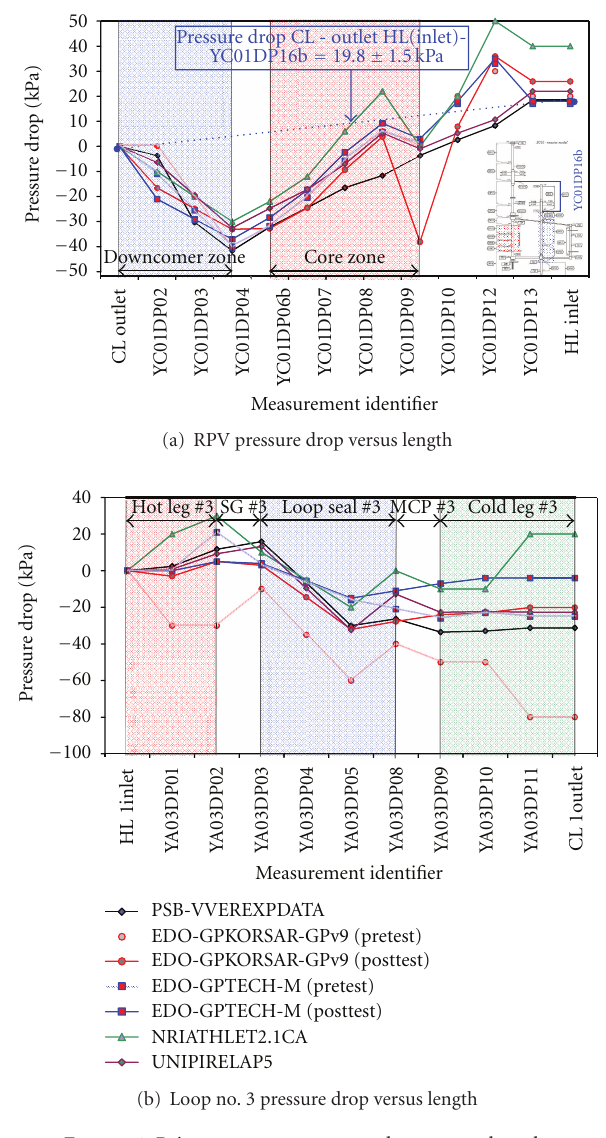
Figure 4: Primary system pressure drop versus